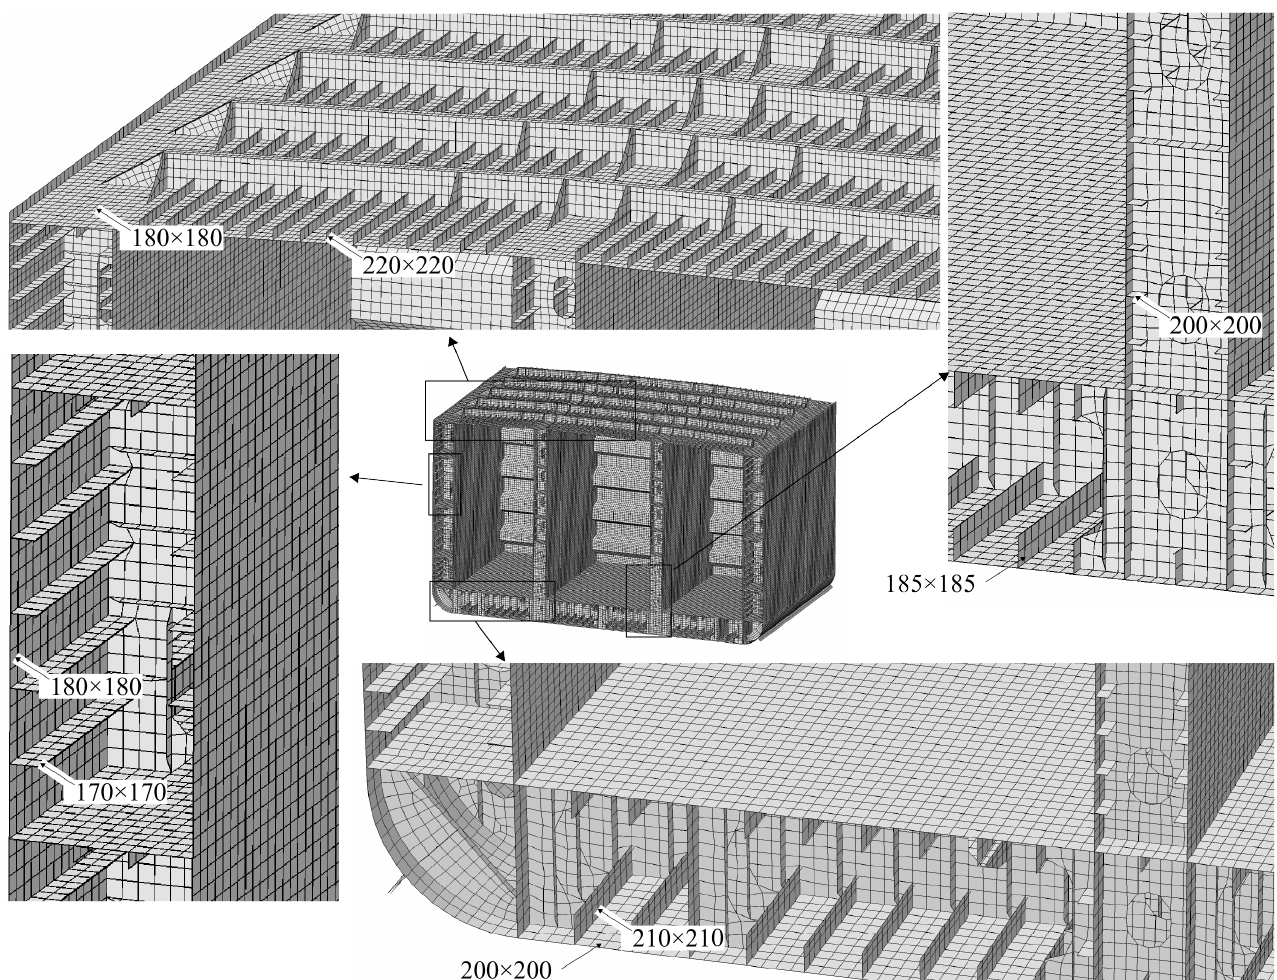
Figure 10. Mesh of the one compartment in the FE-model of chemical